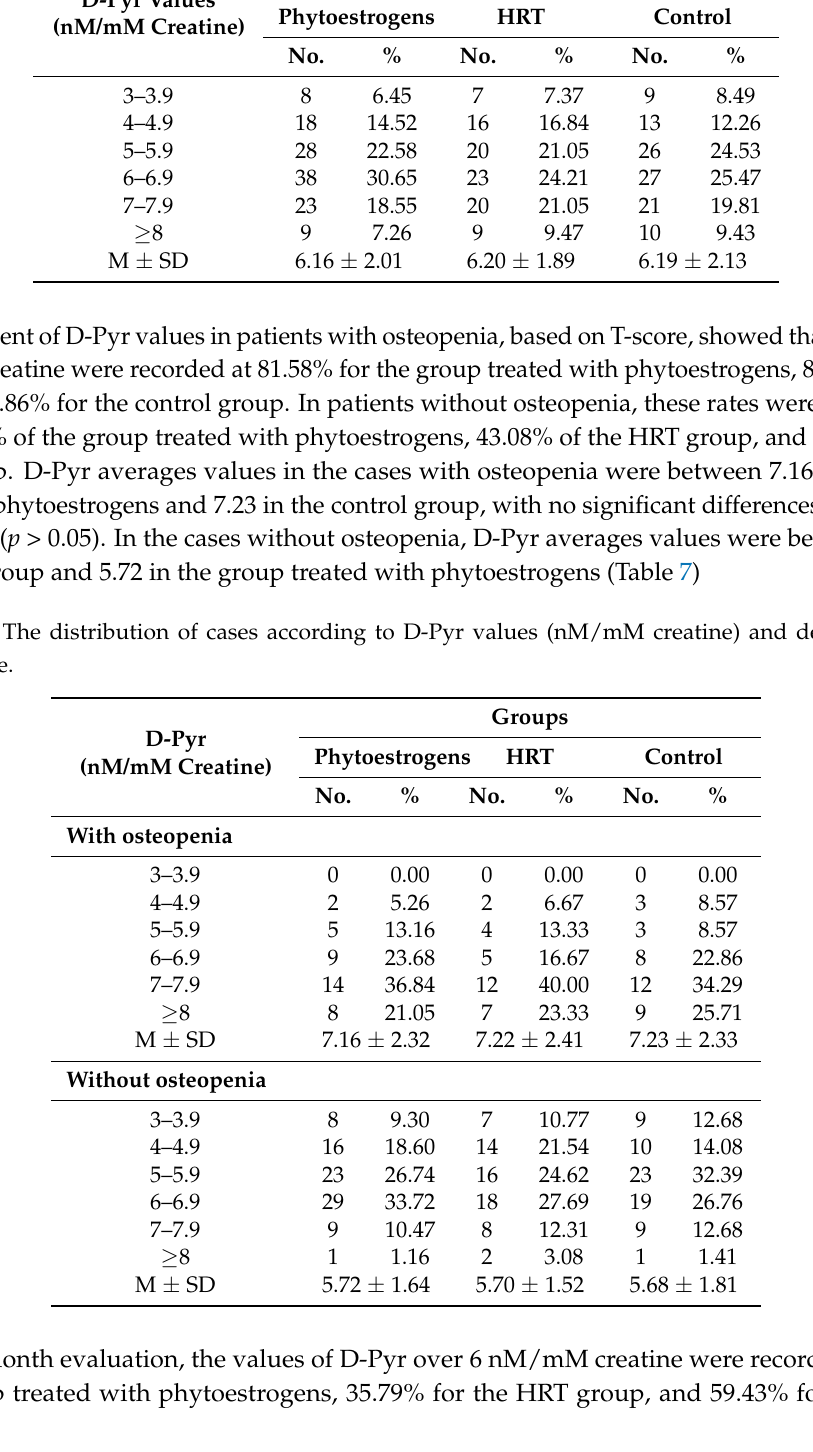
Table 6. The distribution of cases according to D-Pyr values (nM/mM creatine) at the base line. D-Pyr Values